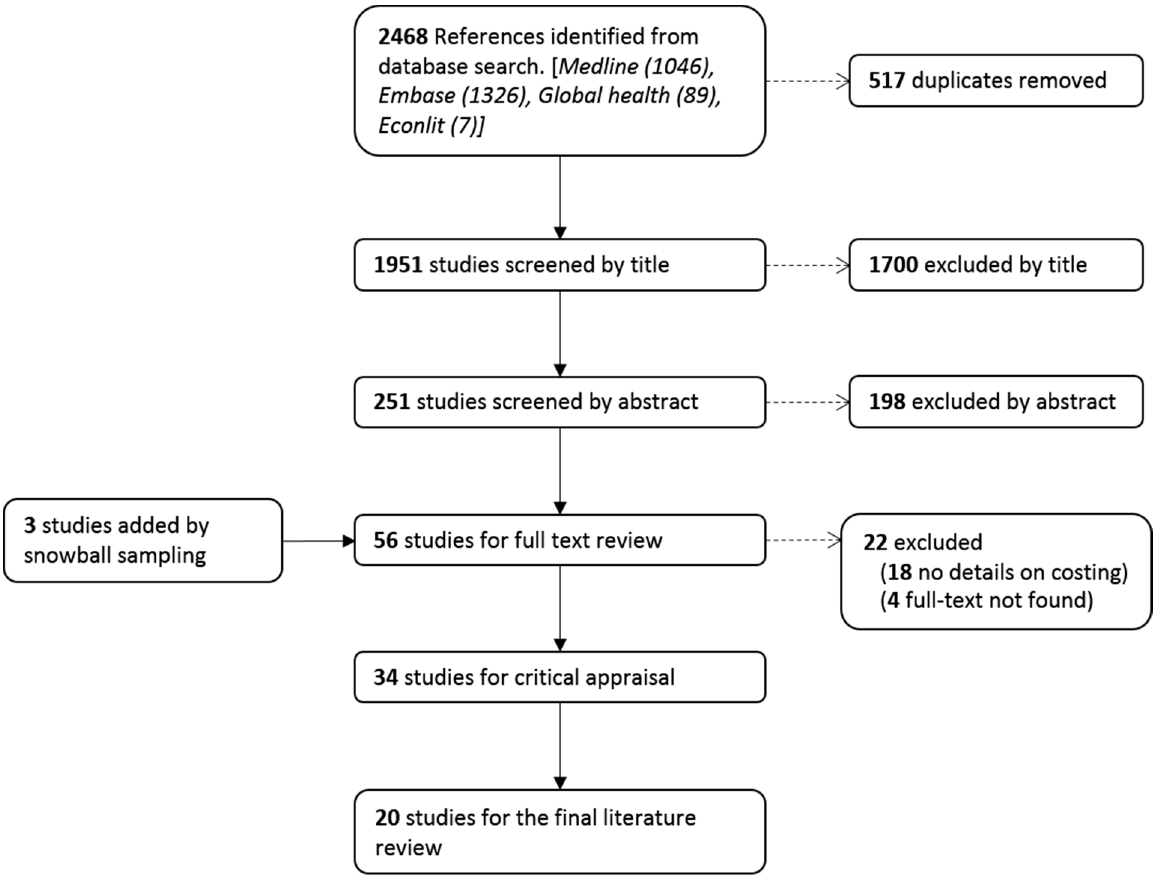
Figure 1. Literature selection process.